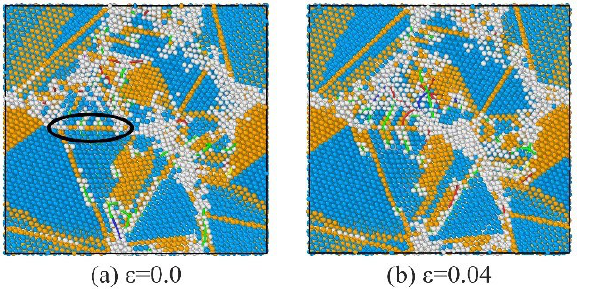
Figure 6. Slices of the evolution of dislocations in defective TBs at the initial stage of shear loading. FCC structures are colored blue, and HCP structures are colored orange, other atoms are colored gray. ( a ) ε= 0.0, ( b ) ε= 0.04.